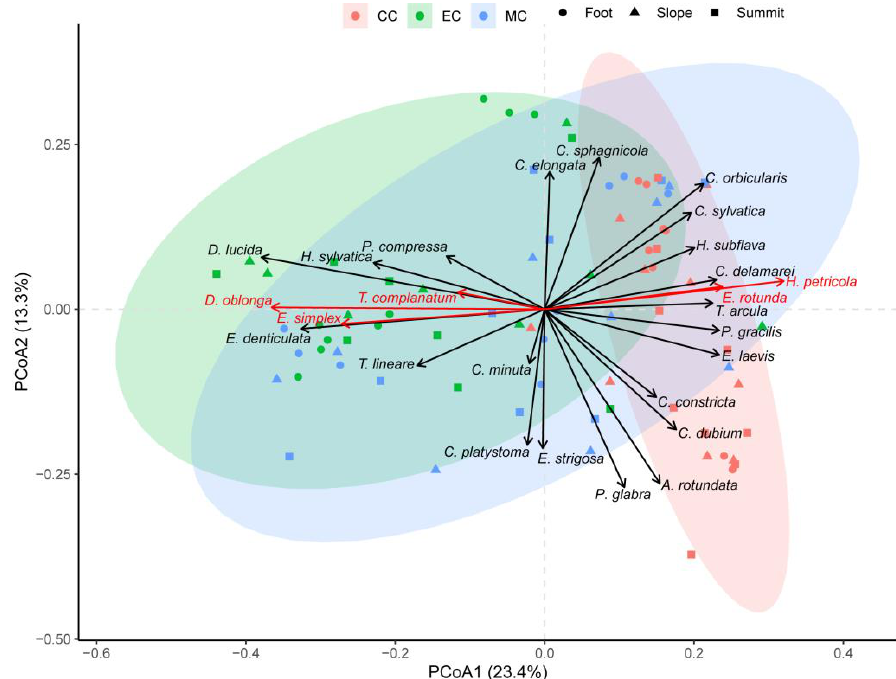
Figure 9. Principal coordinate analysis (PCoA) diagram indicates the differences in species structure of TA communities among three under-crown positions. Red arrows are indicator species obtained by indicator species analysis. CC — the center of the crown, MC — the middle of the crown, EC — the edge of the crown. Table 1. The most abundant and the most common species under the three tree crown positions. (Relative abundance: the number of individuals of a species as a proportion of the total number of individuals of all species per gram of soil. Occurrence: the number of occurrences of a species in the samples as a proportion to the total number of samples).